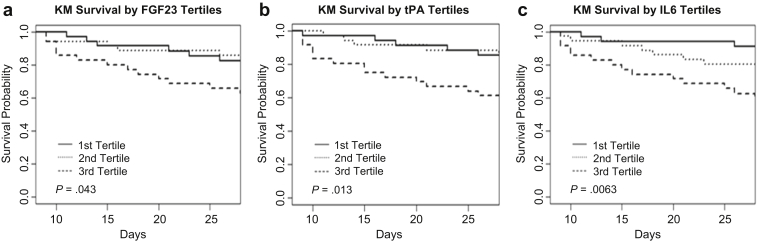
Day 8 cohort event-free survival stratified by biomarker tertiles. (a) Fibroblast growth factor 23 (FGF23), (b) tissue plasminogen activator (tPA), and (c) interleukin-6 (IL-6). KM, Kaplan-Meier.